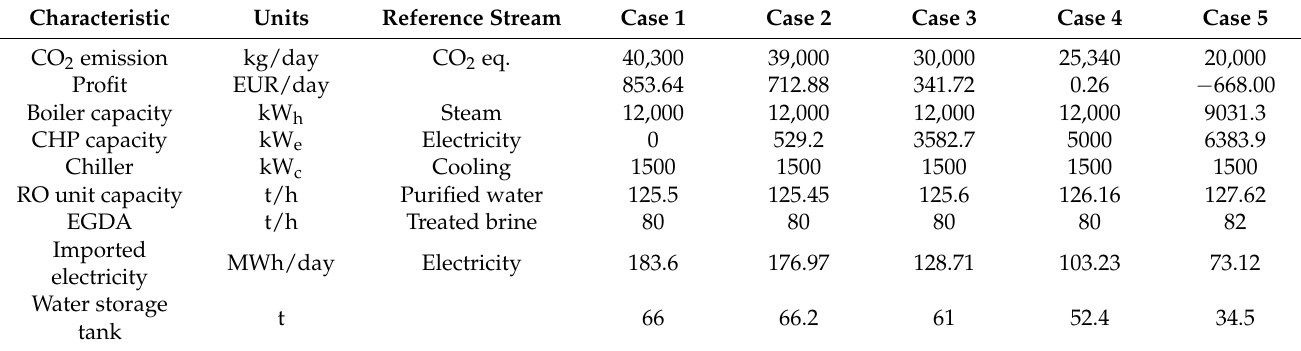
Table 5. Best solutions in terms of profit for 5 selected cases of maximum CO 2